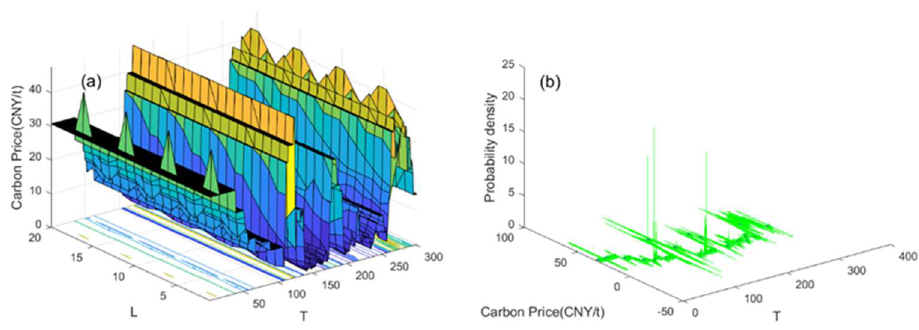
Figure A1. Price data and probability density distribution of carbon market in Beijing, ( a ) evolu- tion of daily closing price data; ( b ) distribution of probability density.